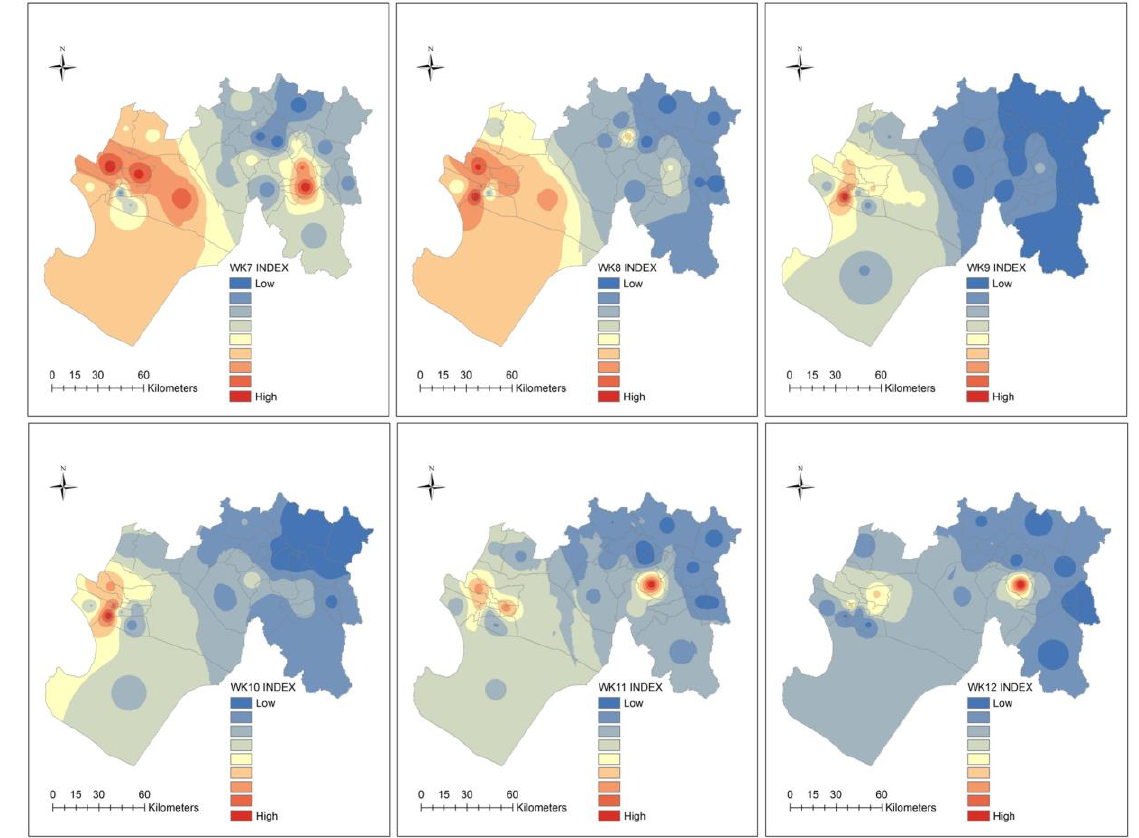
Figure 6. Maps of the ecosyndemic index (low—blue to high—red) at the district-level by week, using the inverse-weight distance interpolation method.